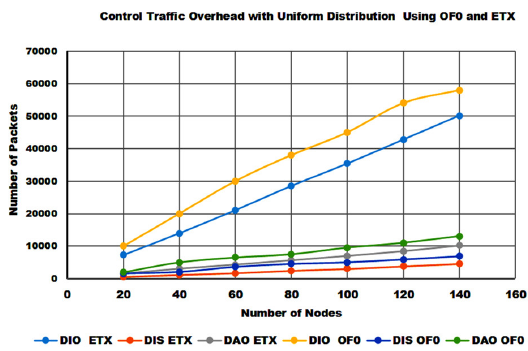
Figure 7. IoT-LAB testbed control traffic overhead with uniform network topology.